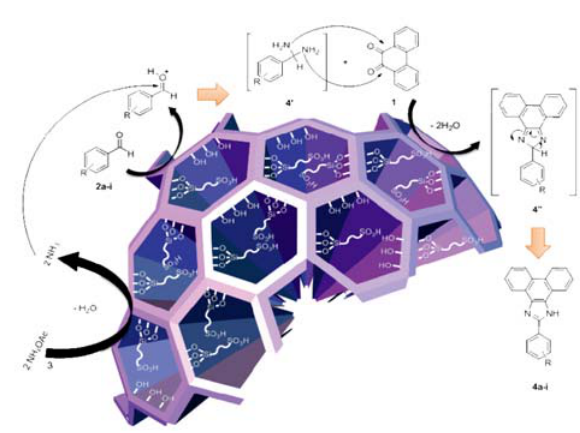
Figure 2. Schematic synthesis of 2,4,5-trisubstituted phenan- throimidazoles ( 4 ).